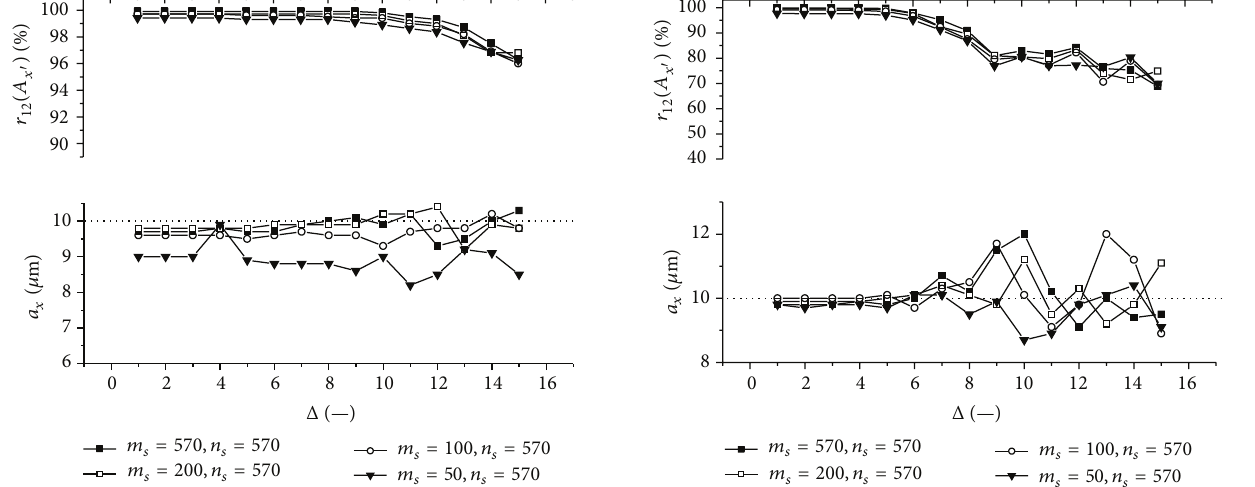
Figure 11: The evaluated object’s translation component 𝑎 𝑥 as well as the maximum 𝑟 12 (𝐴 𝑥 󸀠 ) of the 1D normalized cross-correlation function of intensity signals 𝐼 1 and 𝐼 2 acquired from decimated 2D intensity signals of various size as a function of the factor Δ . Mean speckle sizes are 𝛼 𝑥 󸀠 = 264.9 𝜇 m and 𝛼 𝑦 󸀠 = 225.5 𝜇 m. The object is translated by 𝑎 𝑥 = 10 𝜇 m and 𝑎 𝑦 = 10 𝜇 m.